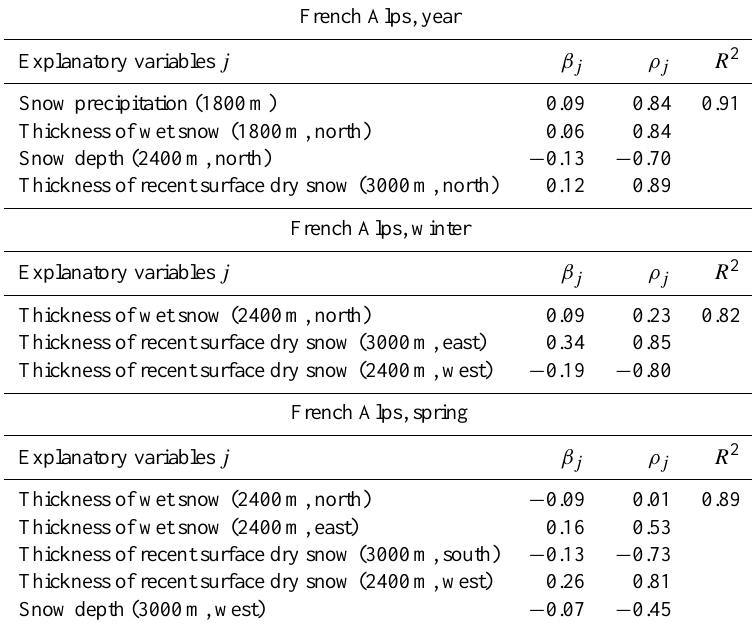
, β j is the corresponding weighting jt , β j and the composite index; and R 2 the determination coefficient of jt French Alps,